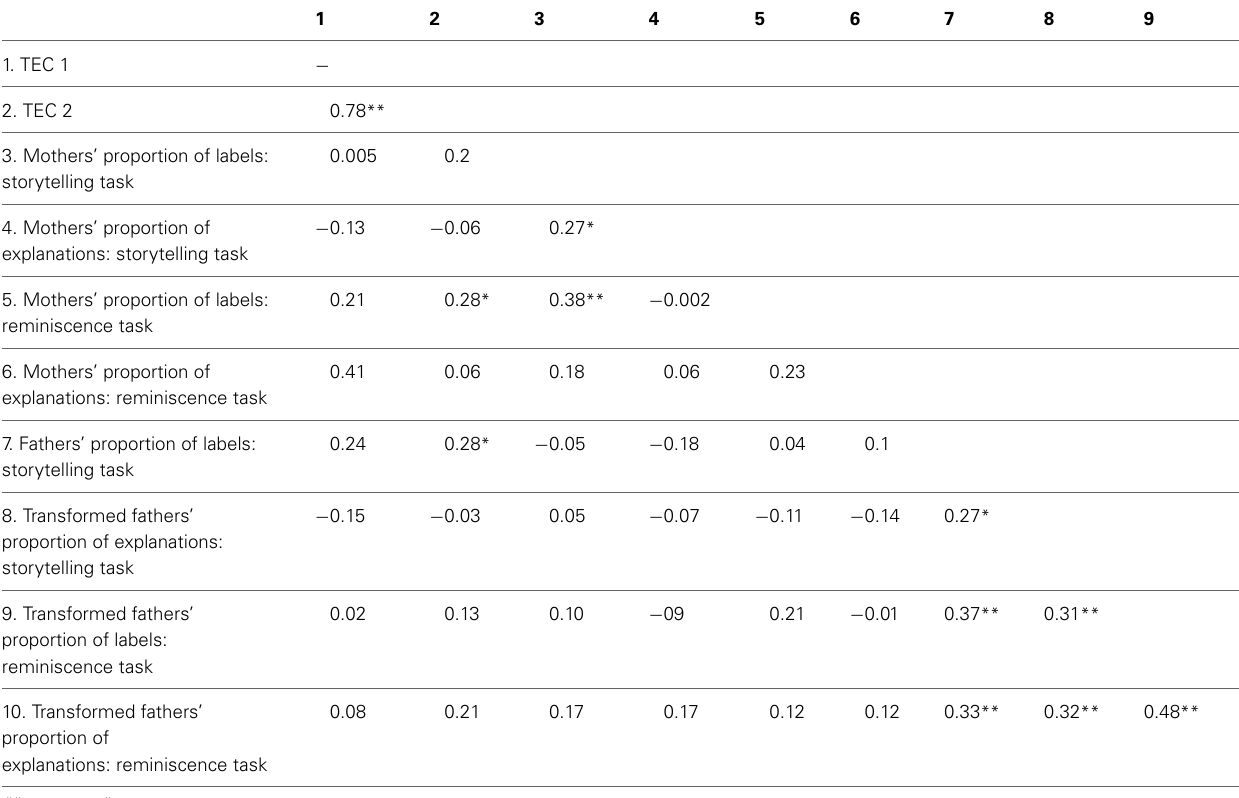
Table 1 | Relations between parental talk and children’s emotion